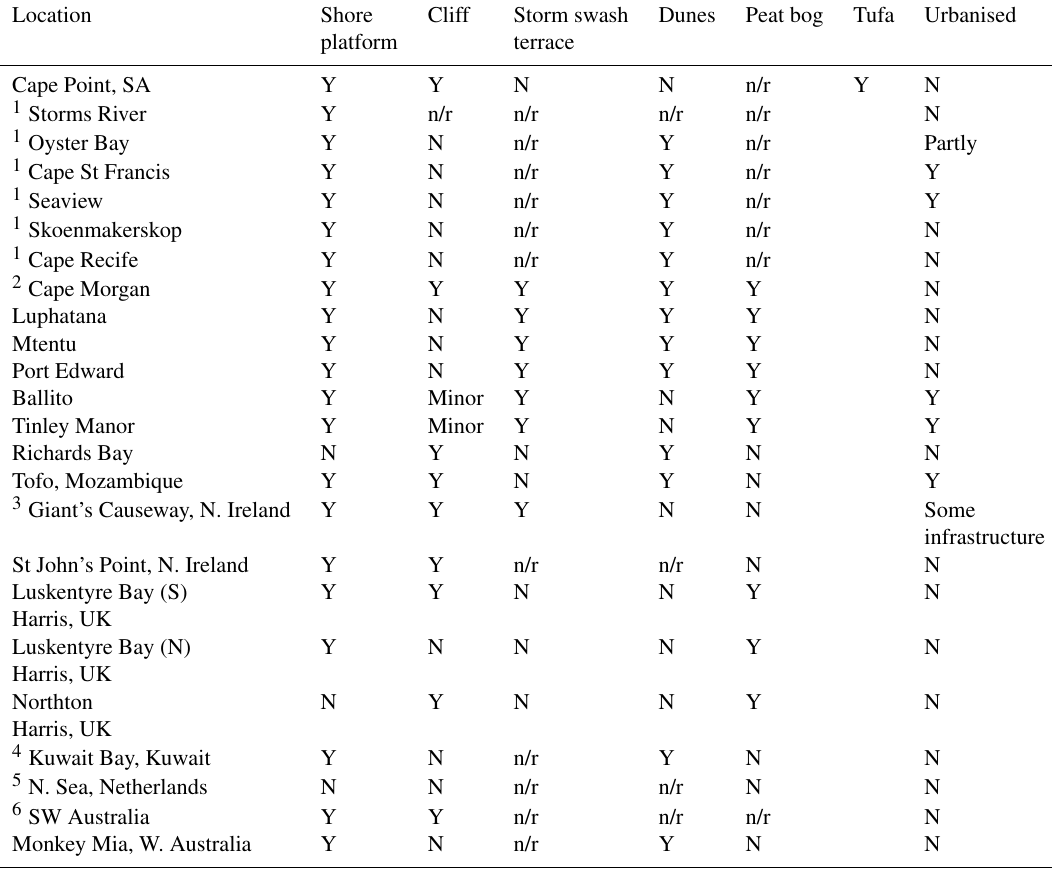
Table 3. Hinterland geology and geomorphology of SPS locations (gaps indicate not recorded).